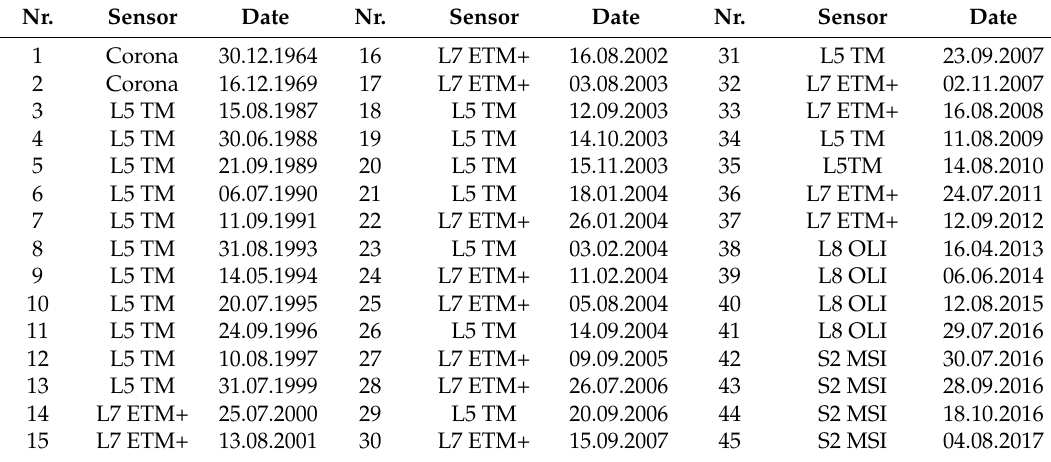
Table A1. Overview of the satellite images used for the analysis. All Landsat scenes have path-row 133-036 and the Sentinel-2 tile used is 47SNU. Corona scenes used: #1: KH-4A scene DS1015-2164DF117, #2: KH-4B scene DS1108-2184DA110. Sensor names: L5 TM: Landsat 5 Thematic Mapper, L7 ETM+: Landsat 7 Enhanced Thematic Mapper plus, L8 OLI: Landsat 8 Operational Land Imager, S2 MSI: Sentinel-2 Multi-Spectral Instrument.